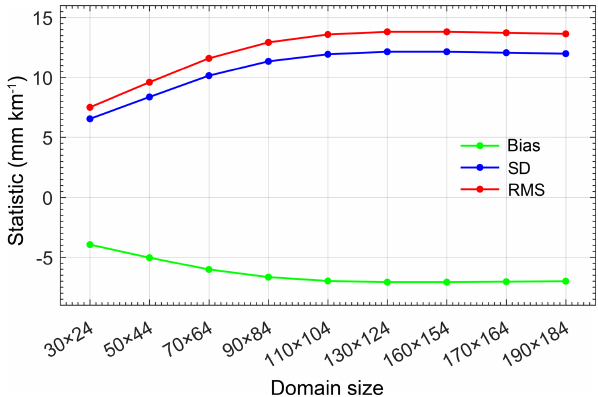
Figure 3. WR statistics of the sensitivity test of domain size vali- dated by radiosonde data.